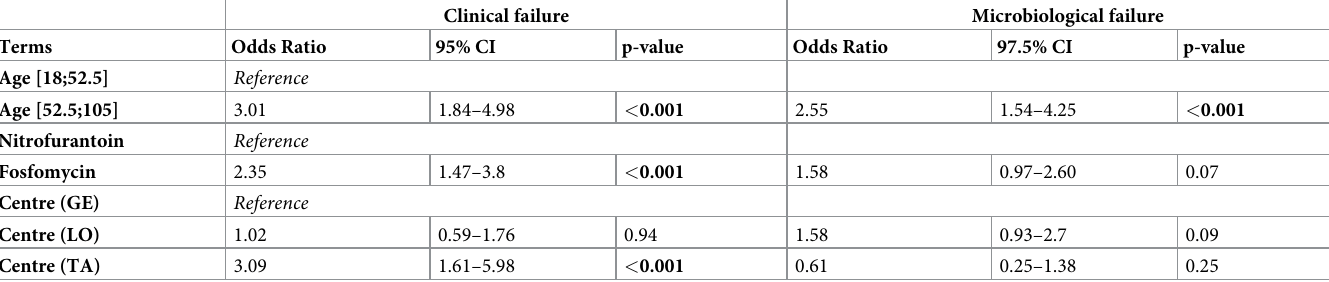
Table 2. Results of multivariate risk factor models in women in the per-protocol population with microbiologically confirmed UTI.